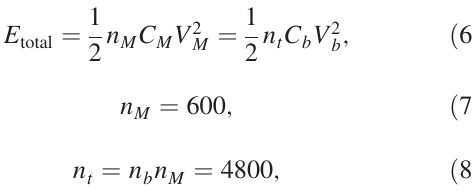
is the one-way transit time of the b